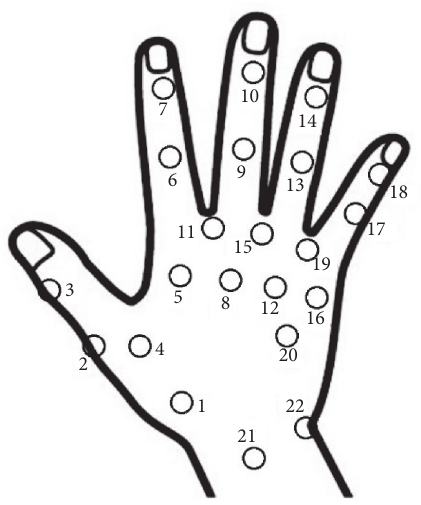
Figure 2: The corresponding position of each CyberGlove II sensor.